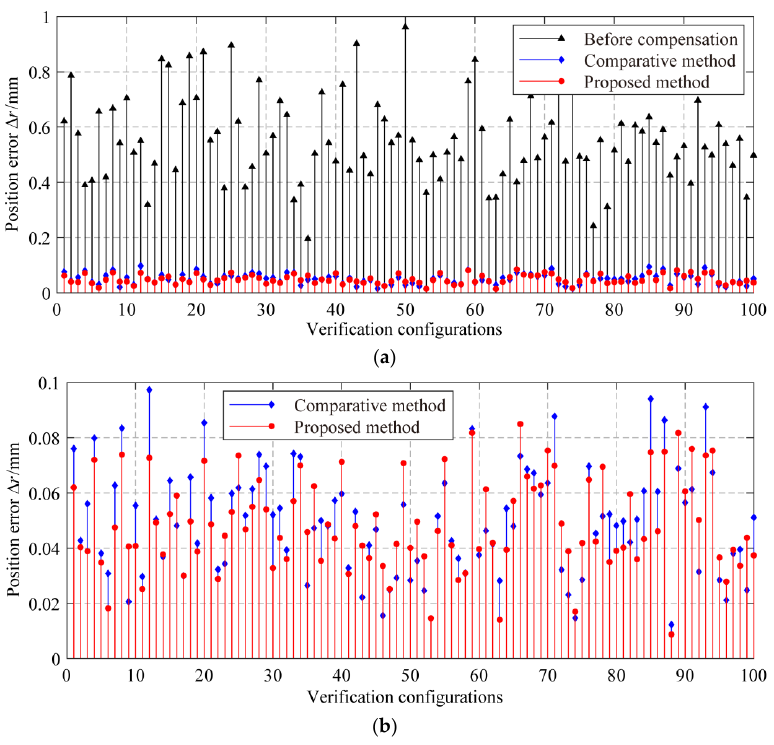
Figure 10. The position errors before and after compensation: ( a ) The position errors; and ( b ) The magnified graph of ( a ), the residual position errors after compensation by two methods.